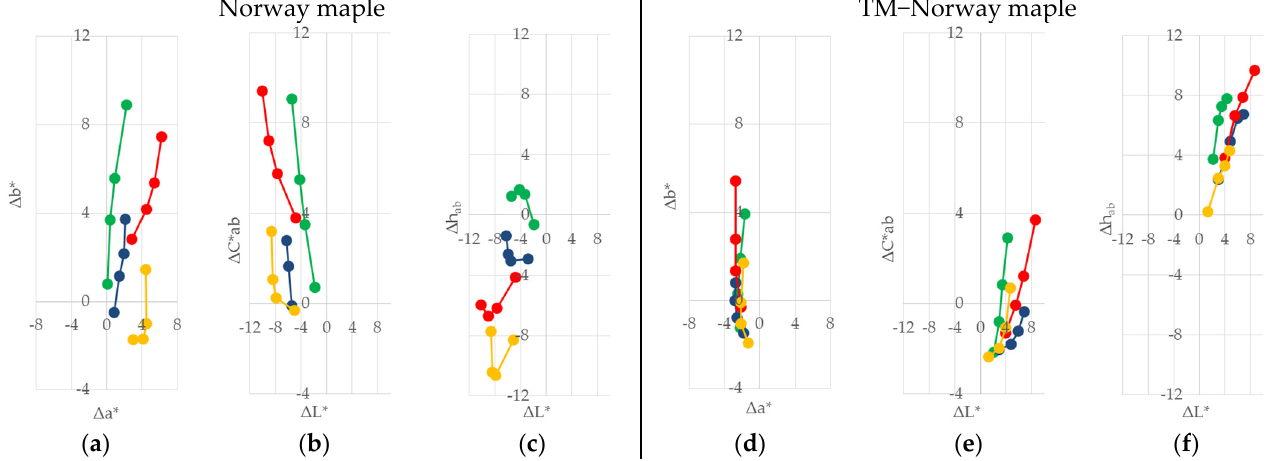
Figure 5. Variations in ∆ L* , ∆ a* , ∆ b* , ∆ C* ab , and ∆ h ab after the exposure to indoor sunlight of coated and uncoated native ( a – c ), and thermally treated ( d – f ), Norway maple wood for 60 days.